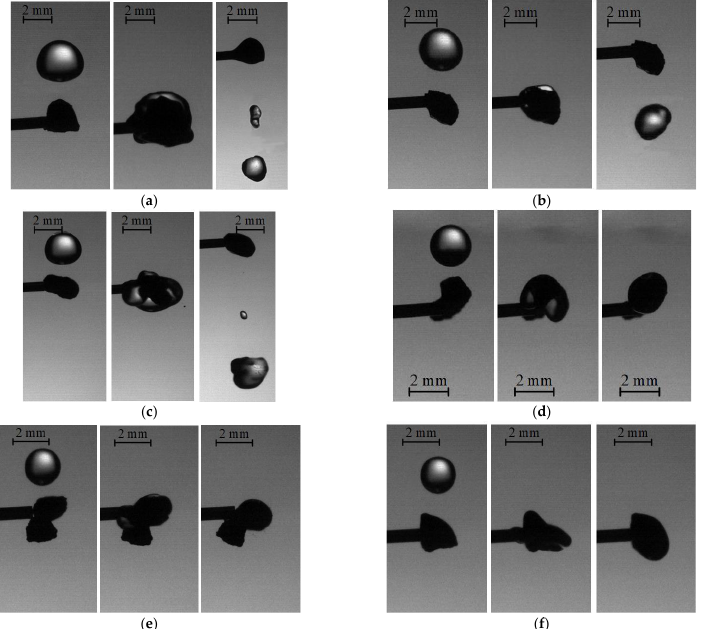
Figure 6. Images of collisions of distilled water droplets with carbonaceous particles of coking coal filter cake at varying droplet sizes: ( a , c , e ) — dry particles; ( b , d , f ) — particles containing water on the surface; ( a , b ) — R d = 1.45 mm; ( c , d ) — R d = 1.3 mm; ( e , f ) — R d = 1.1 mm.